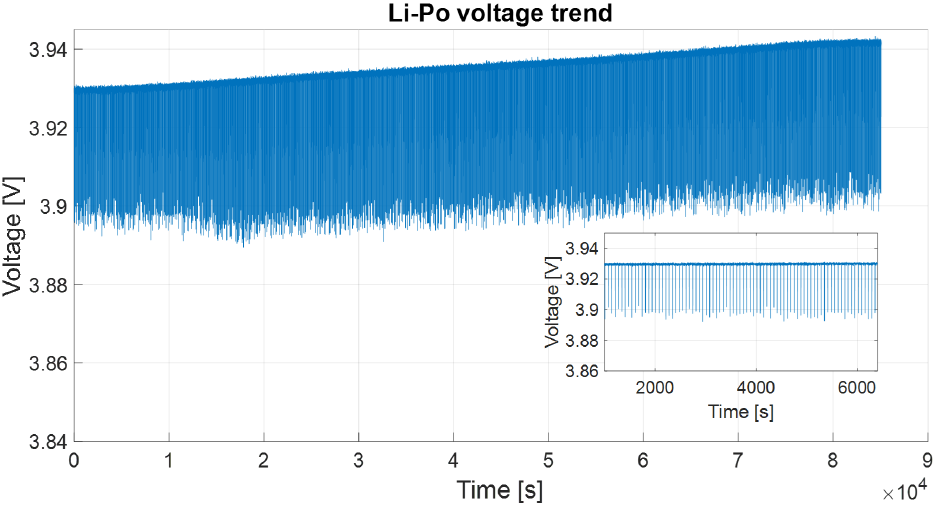
Figure 9. Li-Po voltage trend with radio transmissions every minute and ∆ T = 15 °C. The inset shows a magnified 90-min section of the plot.